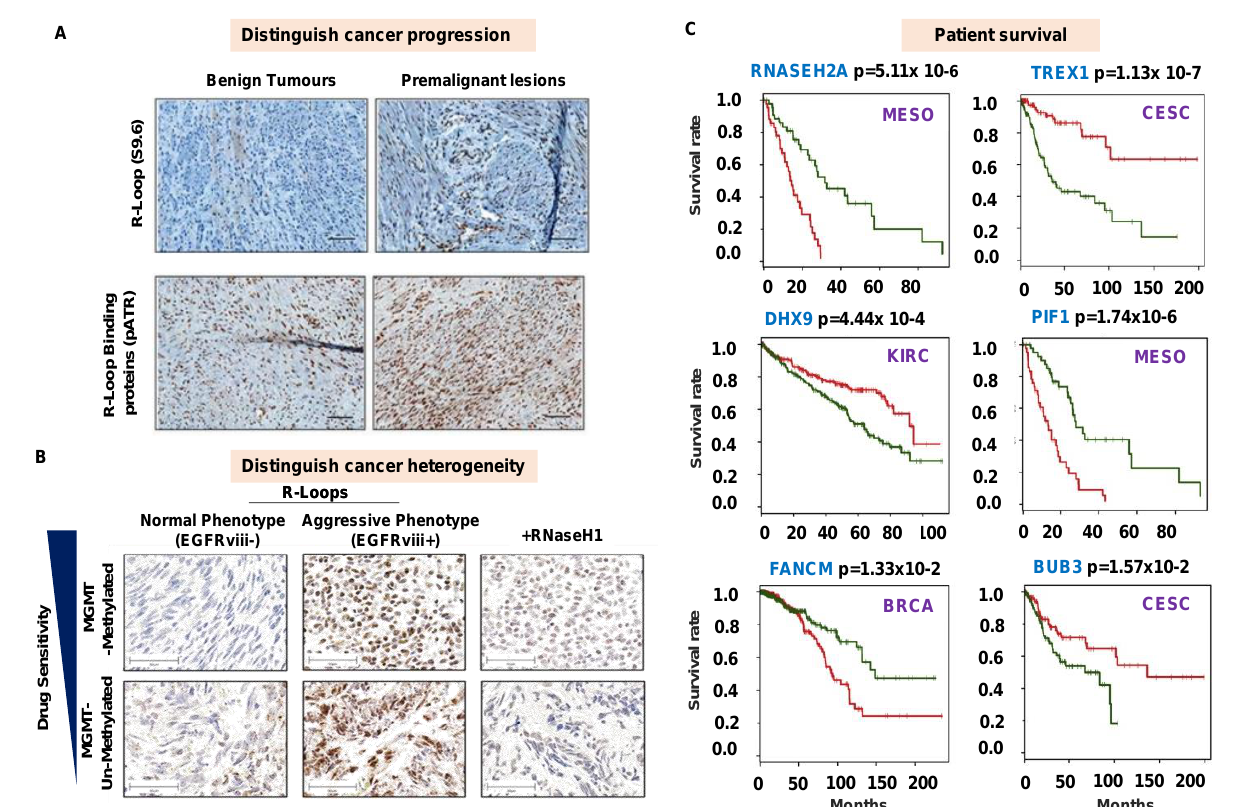
Figure 2. R-loops and R-loop-binding proteins as biomarkers. ( A ). Benign and Premalignant tumor Uterine fibroids are tissue-specifically characterized by aberrant R-loop accrual and its binding protein . Immunohistochemistry (IHC) staining with (upper panel) R-loop-specific S9.6 and (lower panel) pATR (Ser428)-specific antibodies indicating phosphorylated (activated) replication stress signaling correlative with R loop accumulation in different mutants (Re-adapted from Ref [124]). ( B ). R loop accumulation used for distinguishing tumor heterogeneity in Glioblastoma (GBM) patients, highlighting distinct biological properties and complementing the readout of established clinical marker for GBM (O6-methylguanine (O6-MeG)-DNA methyltransferase (MGMT)) . IHC staining of nonaggressive versus aggressive phenotype GBM. Epidermal growth factor receptor variant III (EGFRvIII) areas are depicted in the left column, and EGFRvIII+ areas are displayed in the middle column. Aggressive phenotype GBM incubated with RNase H1 (shown in right column) before immunohistochemical staining with S9.6 antibody is used as specificity control (removing R-loops) for staining, indicating that increased EGFRvIII expression is associated with an increase in R loop accumulation predisposed to DNA damage and genomic instability (Re-adapted with Creative Commons CC-BY-NC license permissions from [126]). ( C ). Representative Kaplan–Meier curves showing the overall survival probability in various cancer types (Mesothelioma (MESO), Cervical and endocervical cancers (CESC), Kidney renal clear cell carcinoma (KIRC), and Breast invasive carcinoma (BRCA)) depending on the gene expression of various R-loop-binding proteins (high and low expression shown in red and green, respectively; R-loop genes, cancer IDs, and p -values are indicated (Re-adapted from